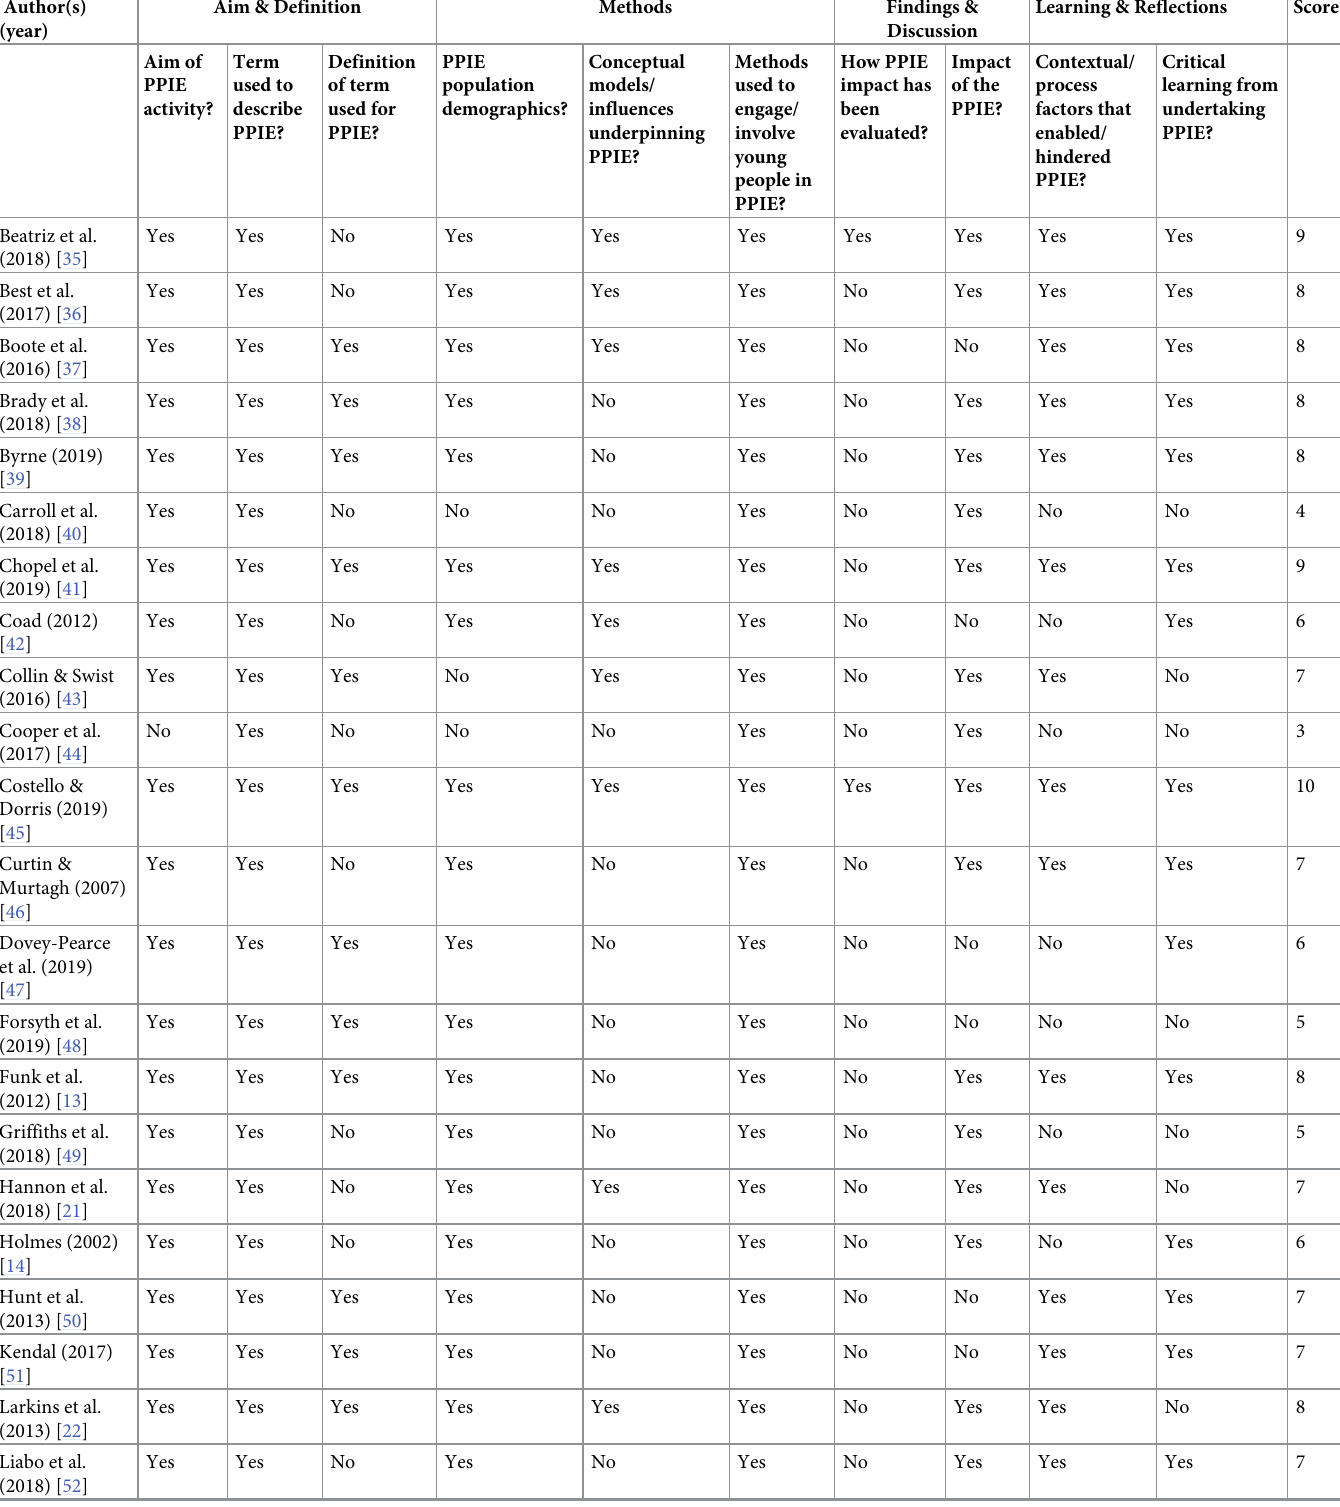
Table 4. Quality of Reporting Involvement and Engagement of Patients and the Public Appraisal Tool (QRIPPAT). Author(s)